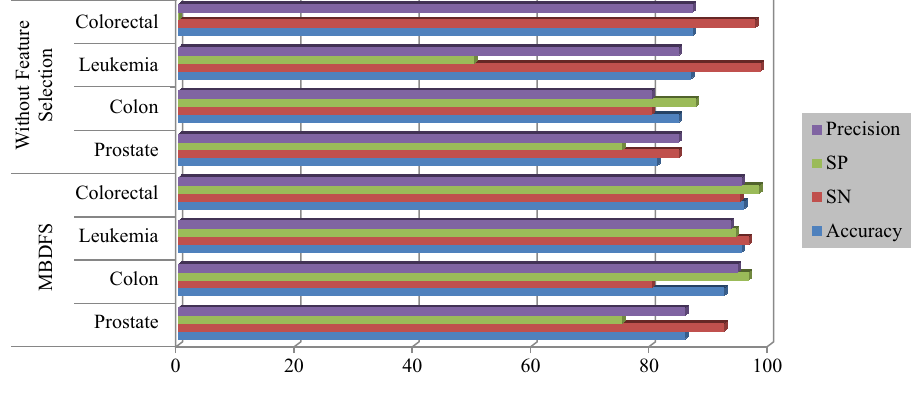
Fig. 4 MBDFS Vs Feature-free Selection